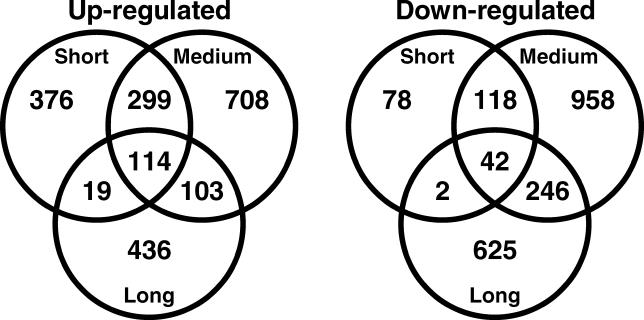
Comparison between Short-, Medium-, and Long-Term Cold Responsive GenesVenn diagrams showing the overlap between genes classified as being up- or down-regulated in response to short-, medium-, or long-term cold treatments. Full details are given in Materials and Methods and Table S2.